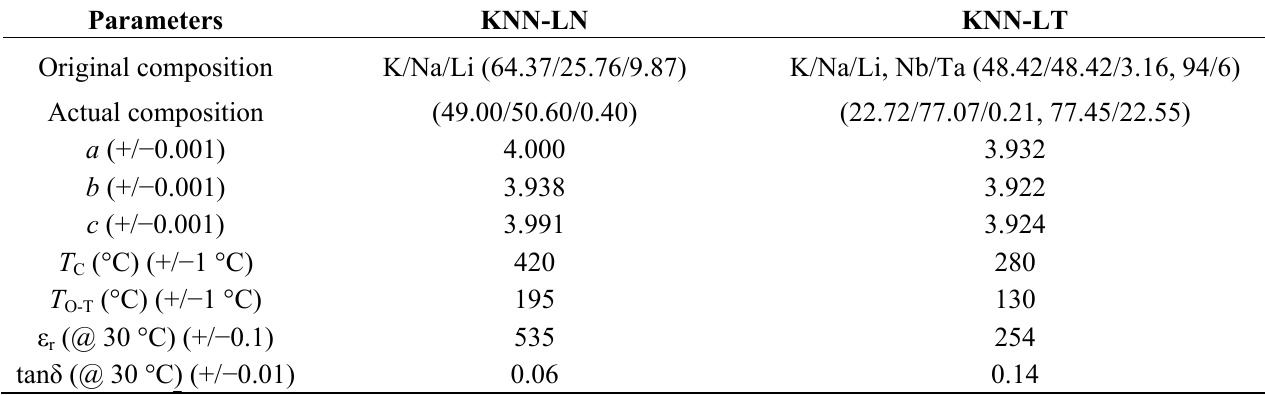
Table 1. Actual composition and physical parameters of (K